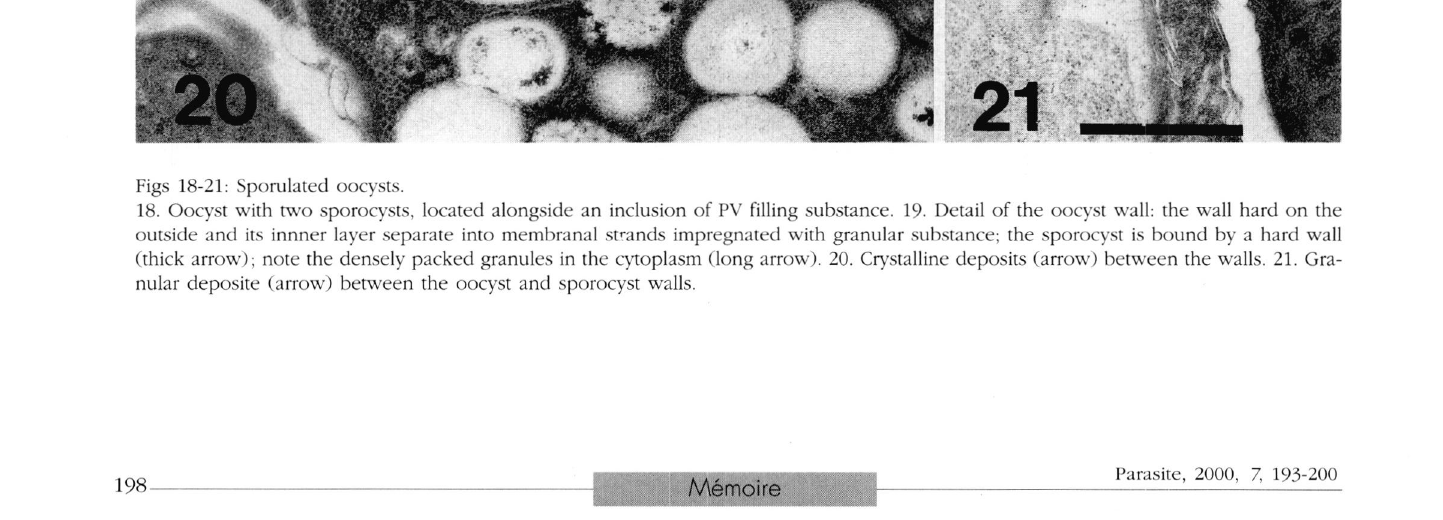
Parasite, 2000, 7,